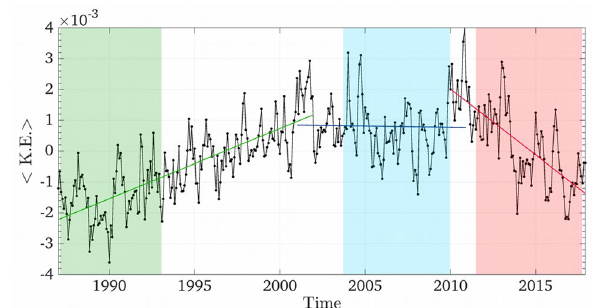
Figure 2. Mean surface kinetic energy timeseries. Monthly time series of deseasonalized surface kinetic energy per unit mass (m 2 /s 2 ), averaged over the whole Mediterranean Sea between 1987 and 2017. The shaded areas indicate the 1987–1993 (during the UP period), 2004–2010 (during MAX) and 2011–2017 (during DOWN) time slots used in Fig.